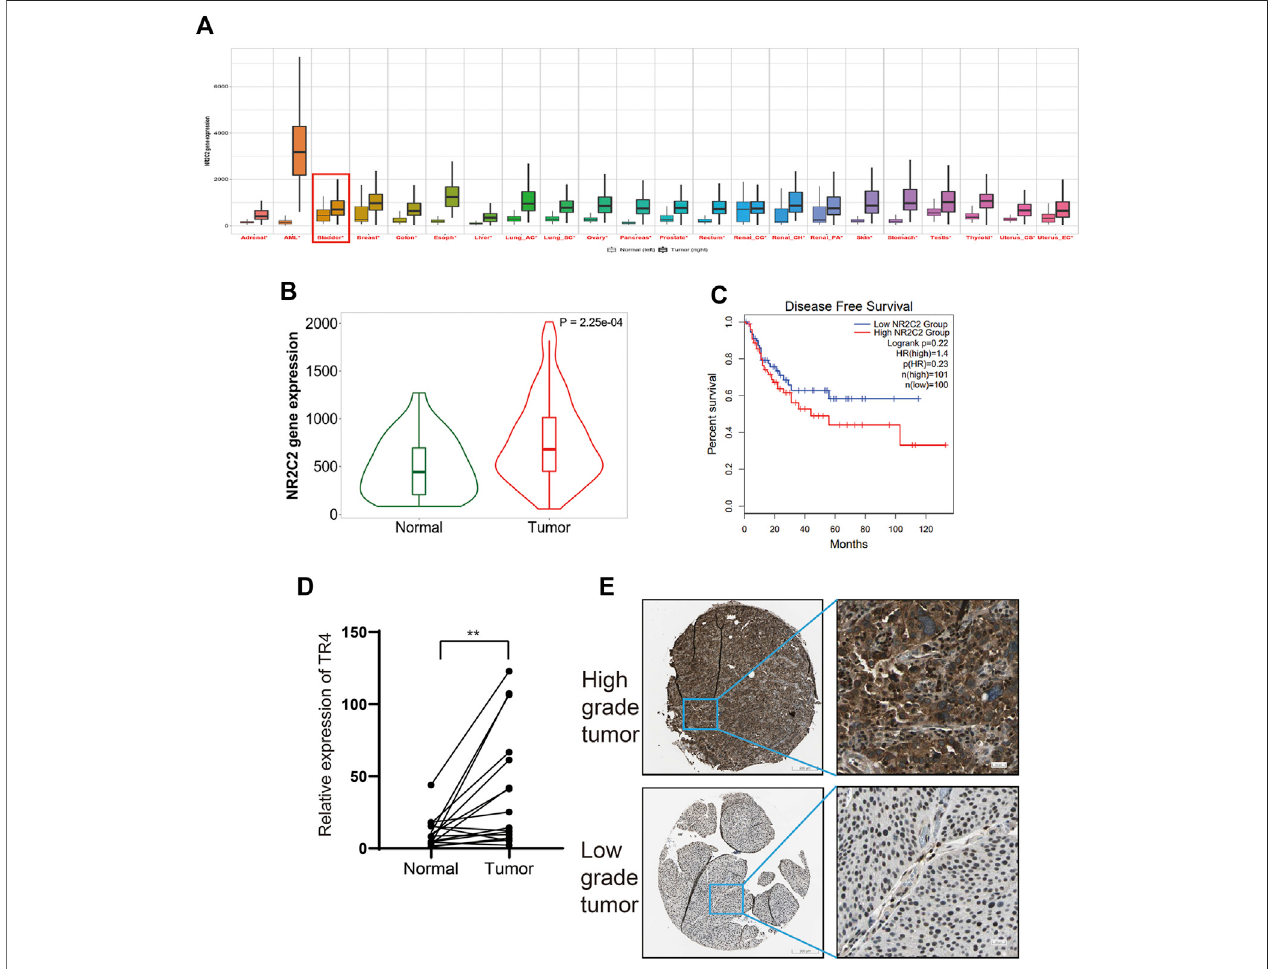
FIGURE 1 | Correlation between TR4 and bladder cancer: (A) Expression of TR4 in pan-cancer, * p < 0.05. (B) Expression of TR4 in bladder cancer, p < 0.01. (C) Relationship between the disease-free survival and the expression of TR4 in bladder cancer, HR: hazard ratio. (D) mRNA level of TR4 in 16 tumor tissues and adjacent tissues, ** p < 0.01. (E) IHC staining results of TR4 levels in high-grade bladder tumor and low-grade bladder